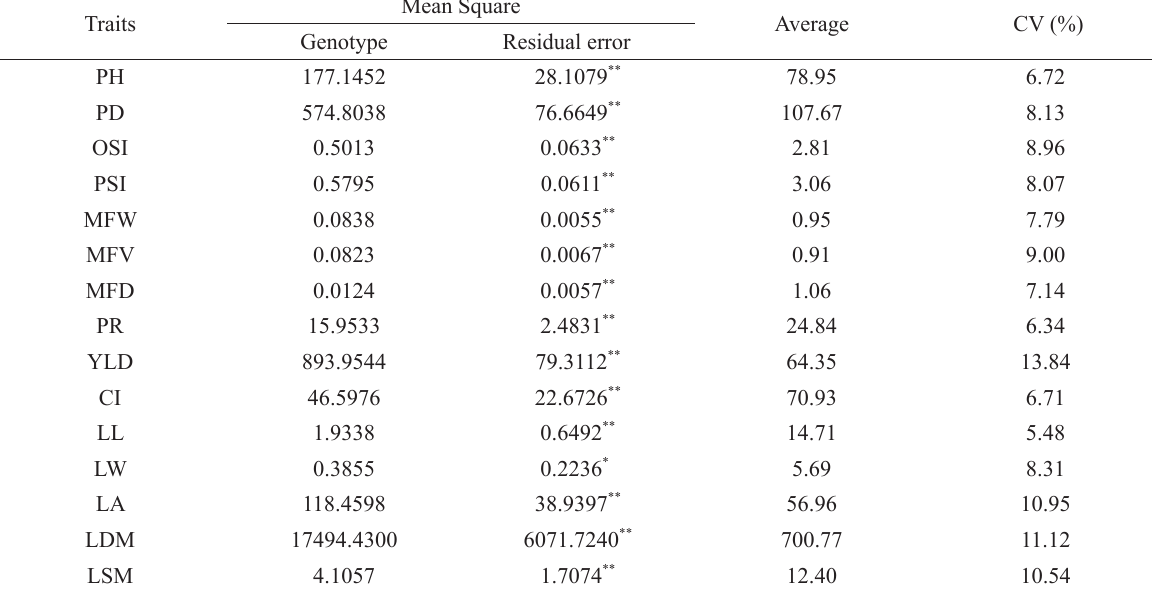
Summary of analysis of variance for 15 morpho-agronomic traits evaluated in 30 promising registered Coffea canephora genotypes Vila Valério - ES,